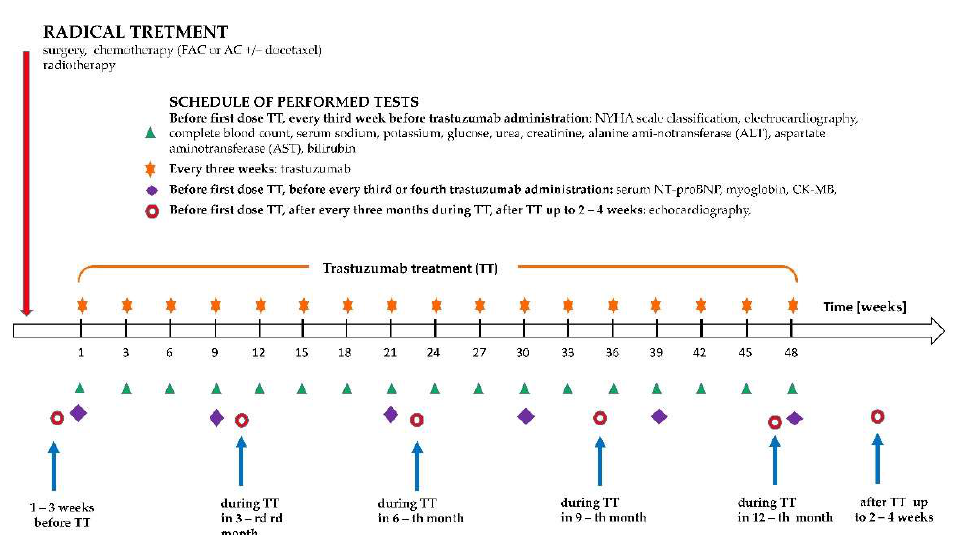
Figure 1. Study design schedule of performed measurements.